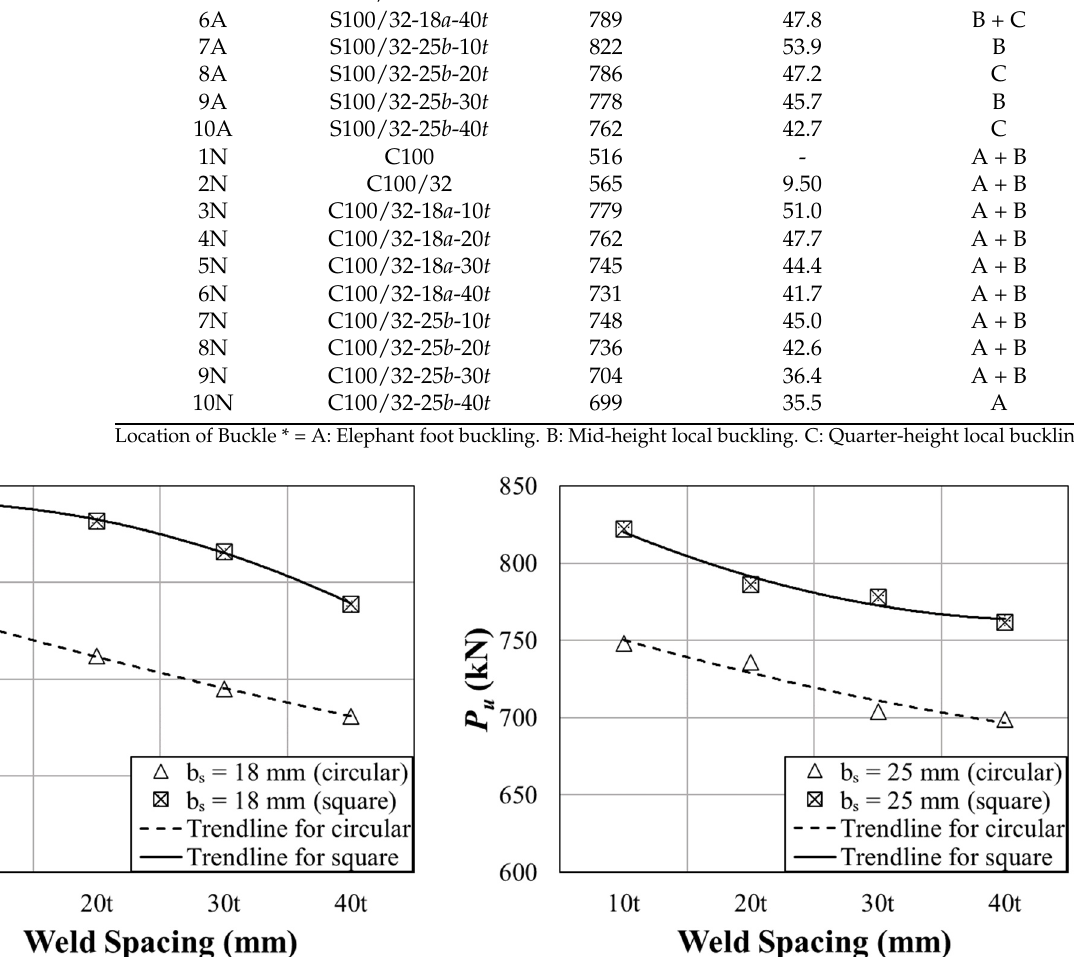
Figure 8. Failure modes of the square and circular specimens. ( a ) Square specimens. ( b ) Circular specimens.